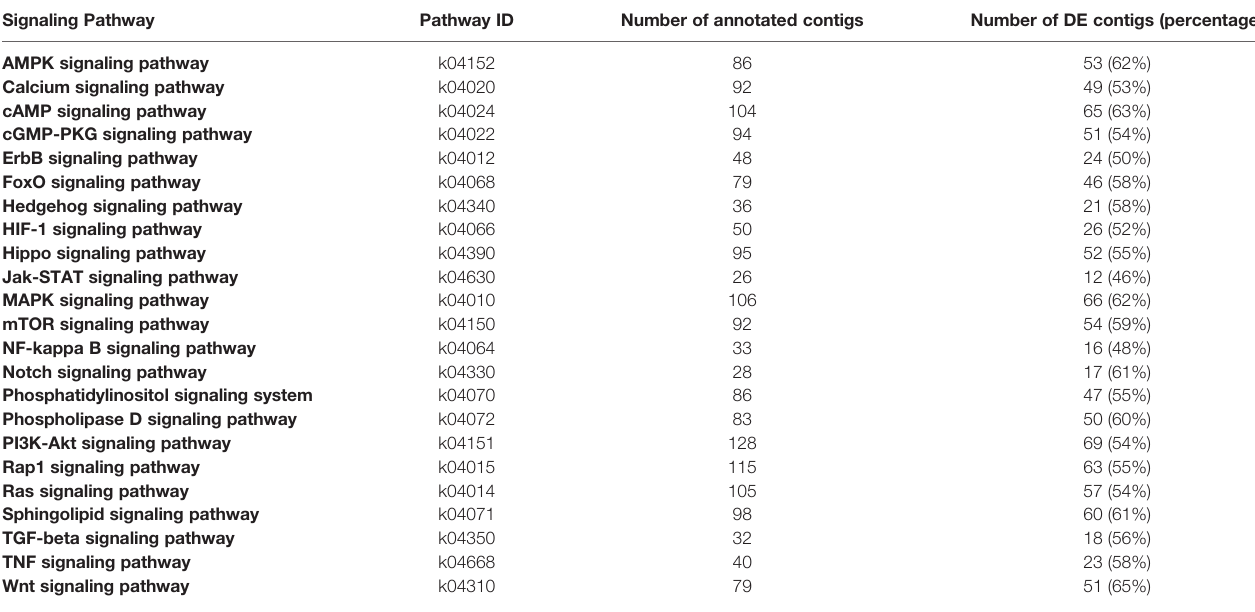
TABLE 1 | Number of total and differentially expressed annotated contigs in the G. lateralis YO transciptome assigned to KEGG signal transduction pathways. From (21). Signaling